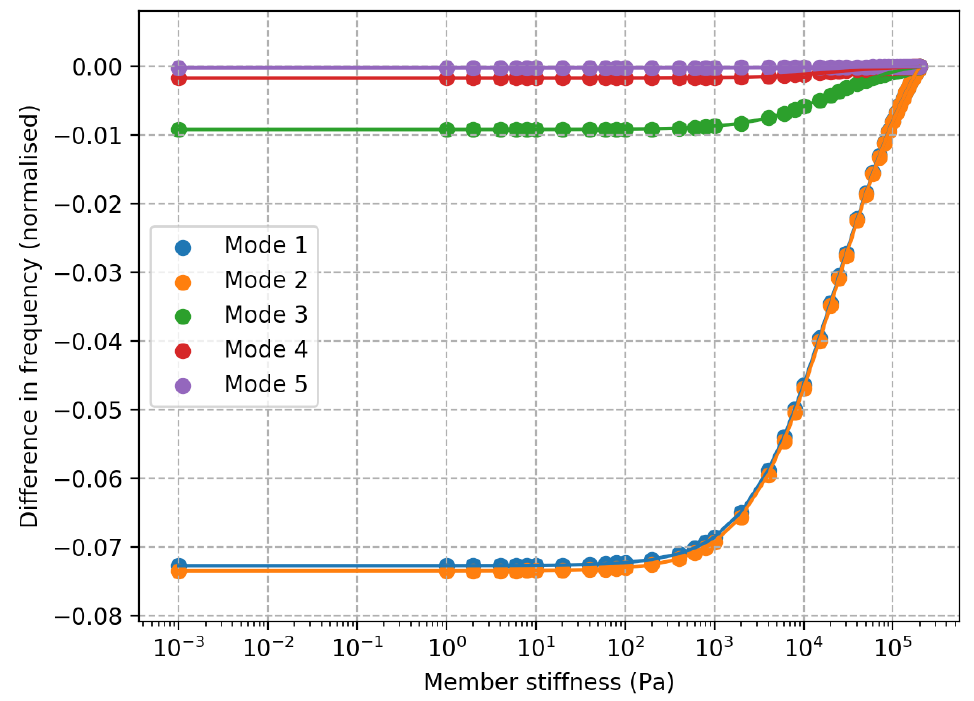
Figure 15. Change in frequency from reduced node stiffness at tower base.